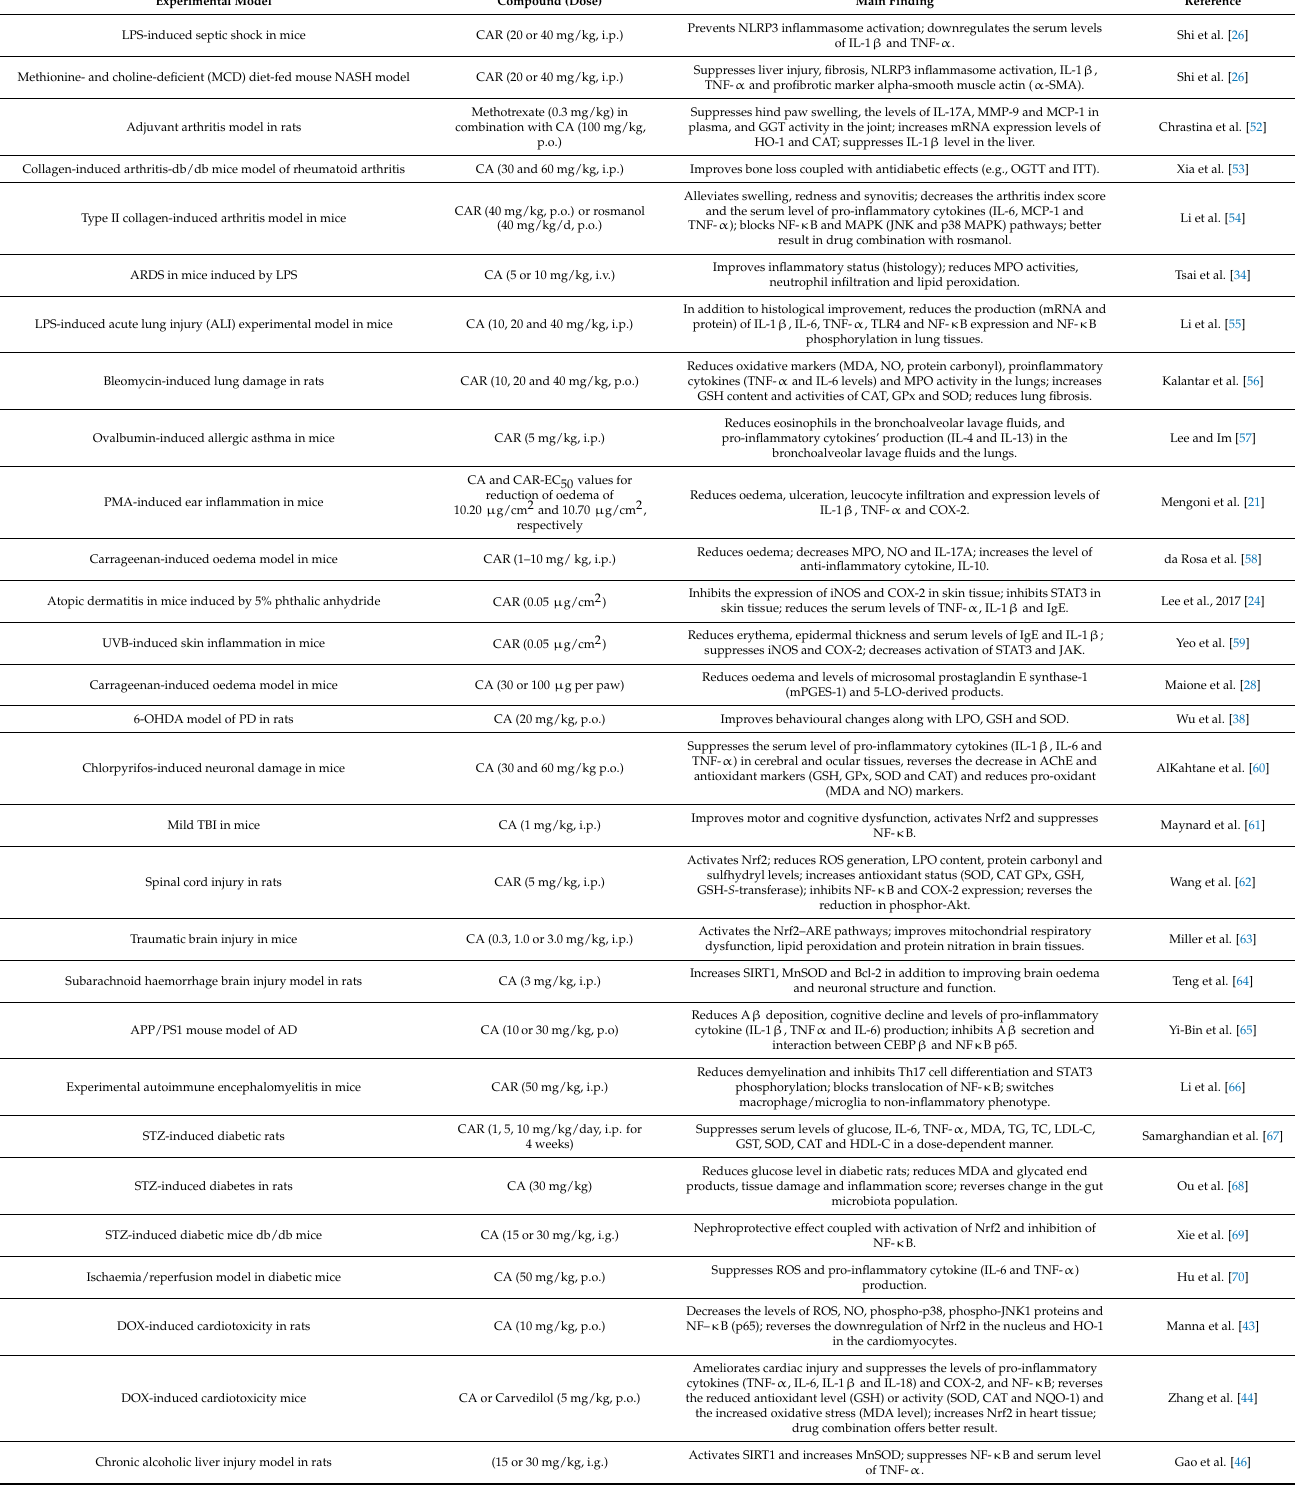
Table 2. Overview of anti-inflammatory mechanisms of CA and CA based on in vivo